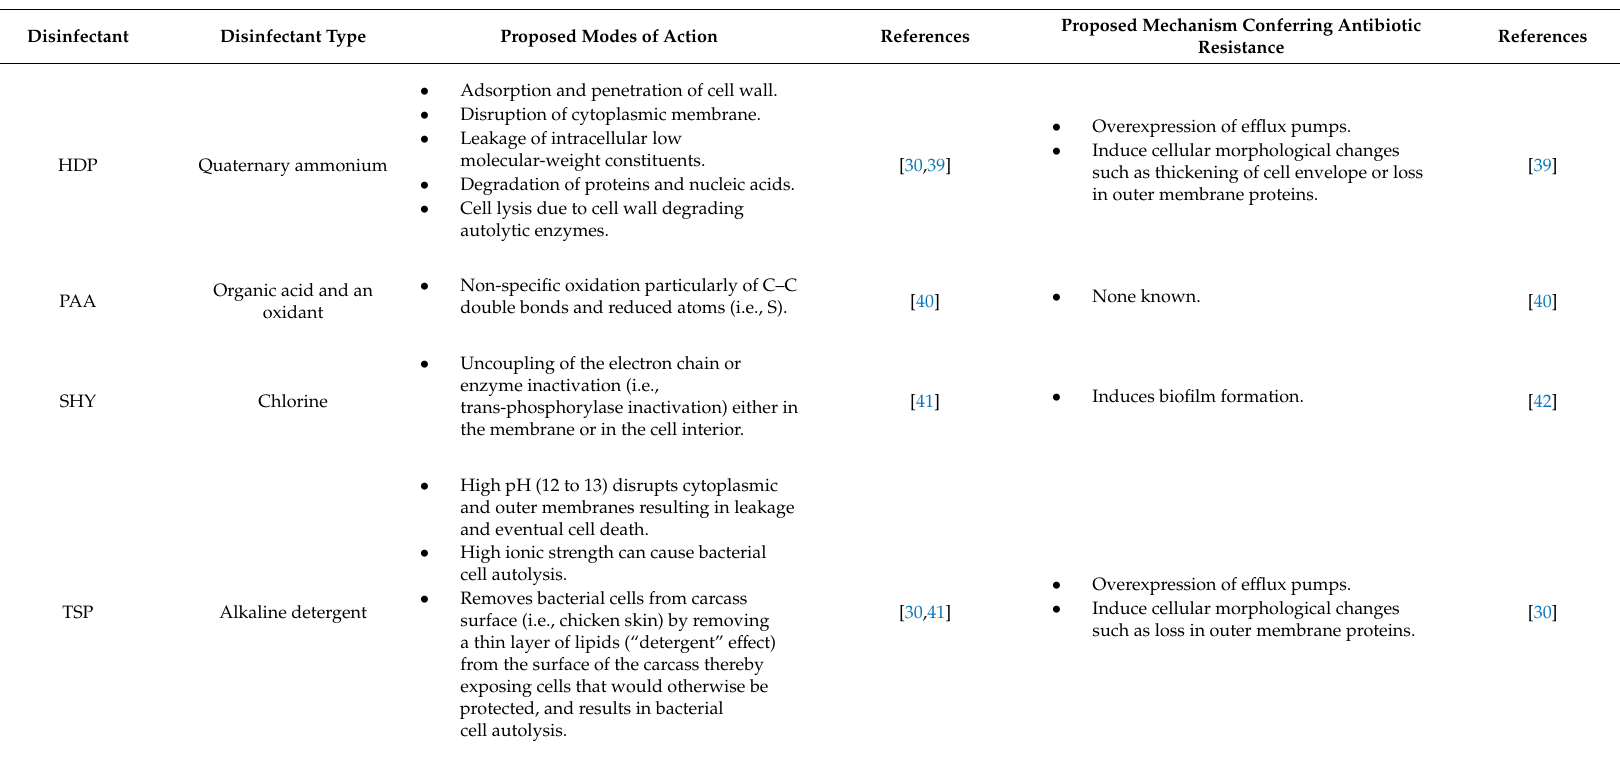
Table 1. Mode of action (MOA) and proposed mechanism of antibiotic resistance for the following commonly used disinfectants in poultry processing: HDP,